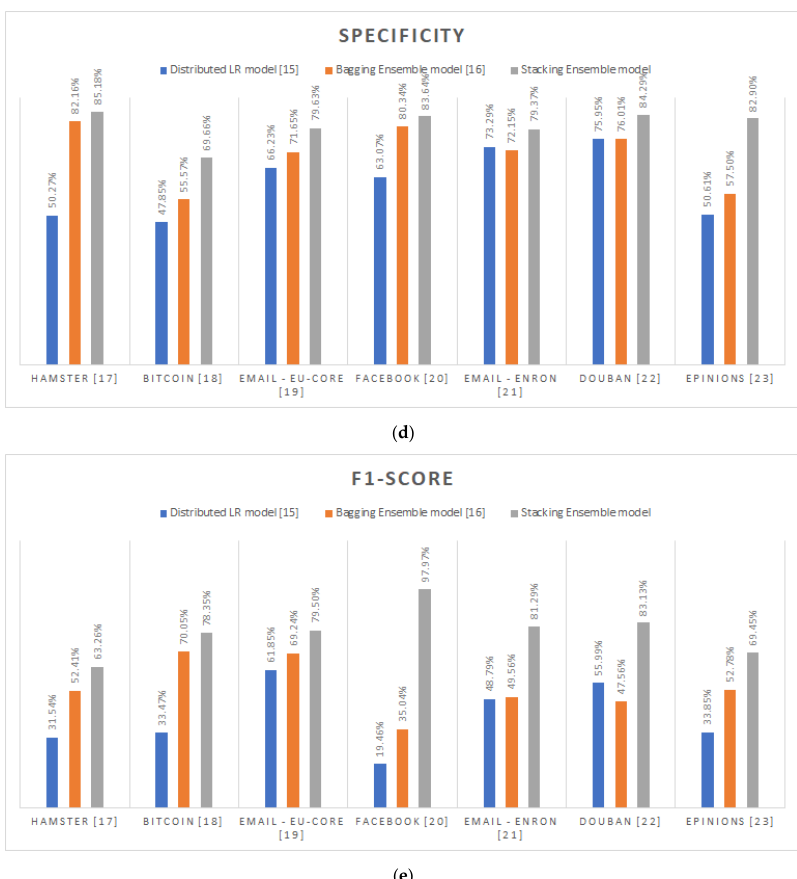
Figure 2. Prediction performance metrics per different community prediction methodology per distinct social graph: ( a ) Accuracy; ( b ) Recall; ( c ) Precision; ( d ) Specificity; ( e ) F1-Score.